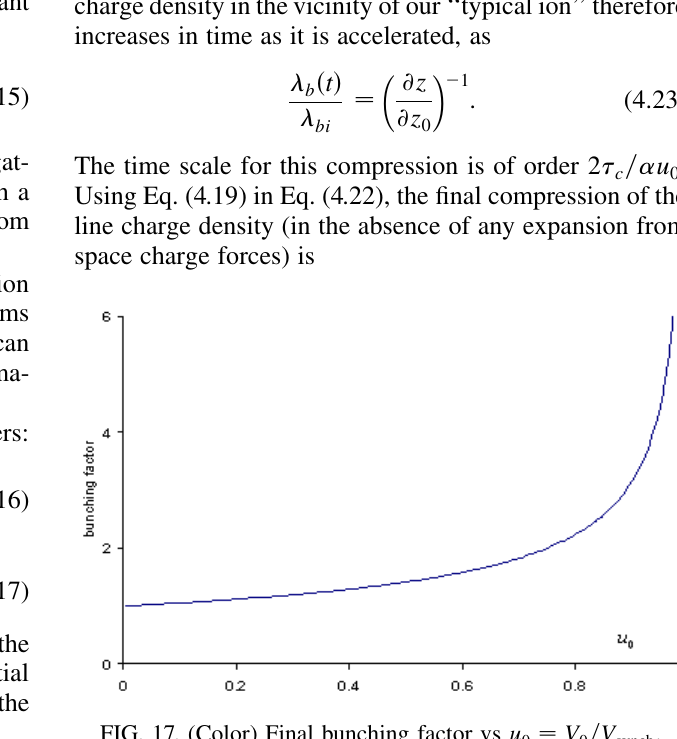
FIG. 17. (Color) Final bunching factor vs u